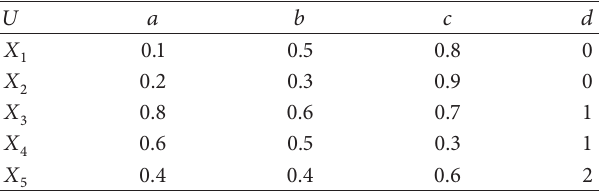
Table 2: Fuzzy attribute information